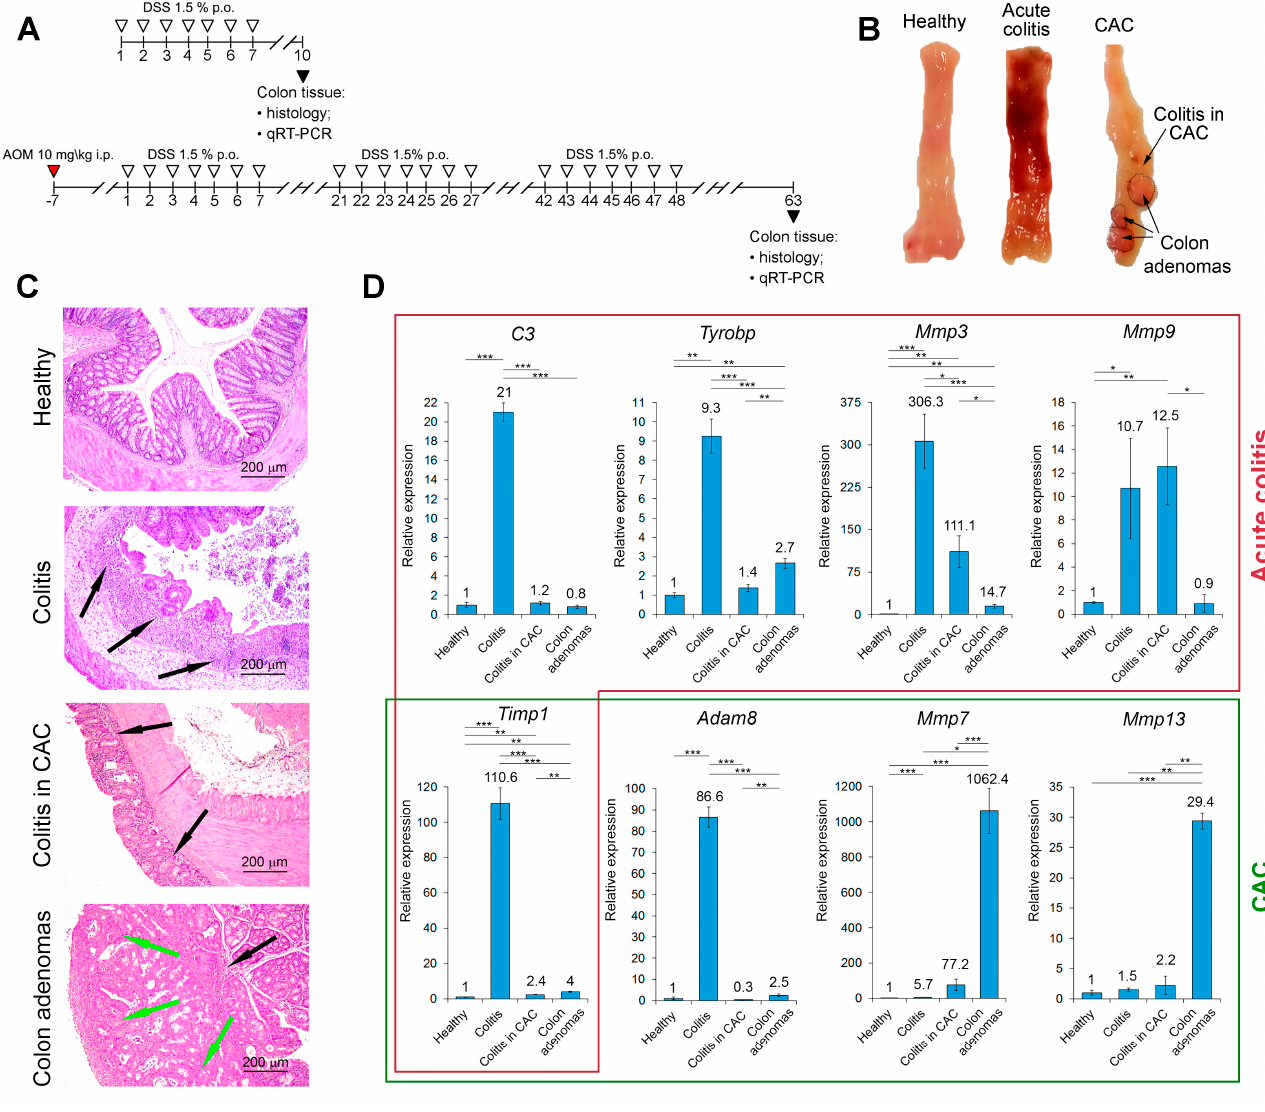
Figure 3. Morphological changes and expression levels of key genes identified by the bioinformat- ics analysis in the colon tissues of healthy mice and mice with acute colitis and colitis-associated cancer (CAC). ( A ) Experimental setup. Acute colitis was induced by the administration of 2.5% dextran sulfate sodium (DSS) solution in drinking water for 7 days followed by a 3 day recovery (upper panel) ( n = 10). CAC was induced in mice by single intraperitoneal (i.p.) injection of azoxymethane (AOM) 1 week before DSS administration. Mice were then exposed to 3 consecutive cycles of 1.5% DSS instillations for 7 days followed by 2 weeks recovery (lower panel) ( n = 10). At the end of the experiment, the colons were collected for subsequent histological analysis and qRT-PCR. ( B , C ) Gross morphology ( B ) and histology ( C ) of the colon tissue of healthy mice and mice with acute colitis and CAC. Hematoxylin and eosin staining. Original magnification ×100. Black arrows indicate inflammatory infiltration. Green arrows indicate adenomatous transfor- mation of colon epithelium. ( D ) Expression levels of identified genes in the colon tissues measured by qRT-PCR. HPRT was used as a reference gene. Healthy—healthy colon tissue, colitis—colon tissue with acute colitis, colitis in CAC—colon tissue with chronic colitis adjacent to adenomas. The data are expressed as the mean ± SD ( n = 6). * p < 0.05, ** p < 0.01, *** p < 0.001. 2.3.2. Core Genes Expression in the Colonic Tissue of Mice with Acute Colitis and CAC Finally, the expression of the revealed hub genes related to acute colitis ( C3 , Tyrobp , Mmp3 , Mmp9 , Timp1 ) and CAC ( Timp1 , Adam8 , Mmp7 , Mmp13 ) was validated by qRT-PCR in the colon tissue of mice with acute colitis and colitis-driven adenomas (Fig-